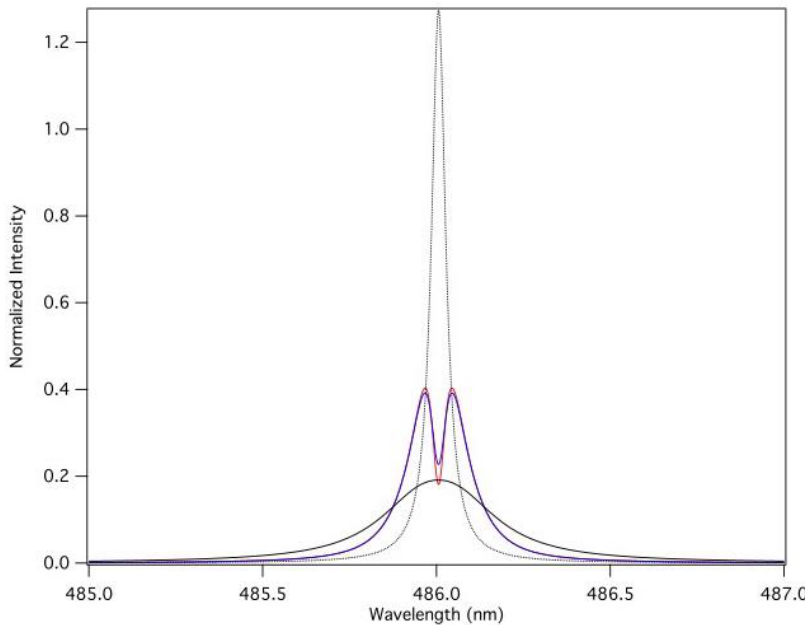
Figure 2. Comparisons between different broadening effects on the H-β line profile in He plasma at n e = 1 × 10 15 cm −3 , T e = 1.16 × 10 4 K, and T i = 300 K. Dotted black line: electronic impact broadening; Red line: total Stark broadening with quasi-static approximation; Blue line: total Stark broadening taking into account ion dynamics effect; Black line: total Stark profile taking into account relevant, Van der Waals, and instrumental broadening.